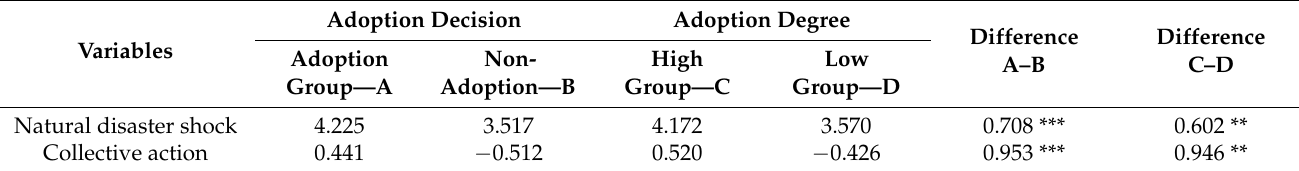
Table 5. The results of the independent samples t